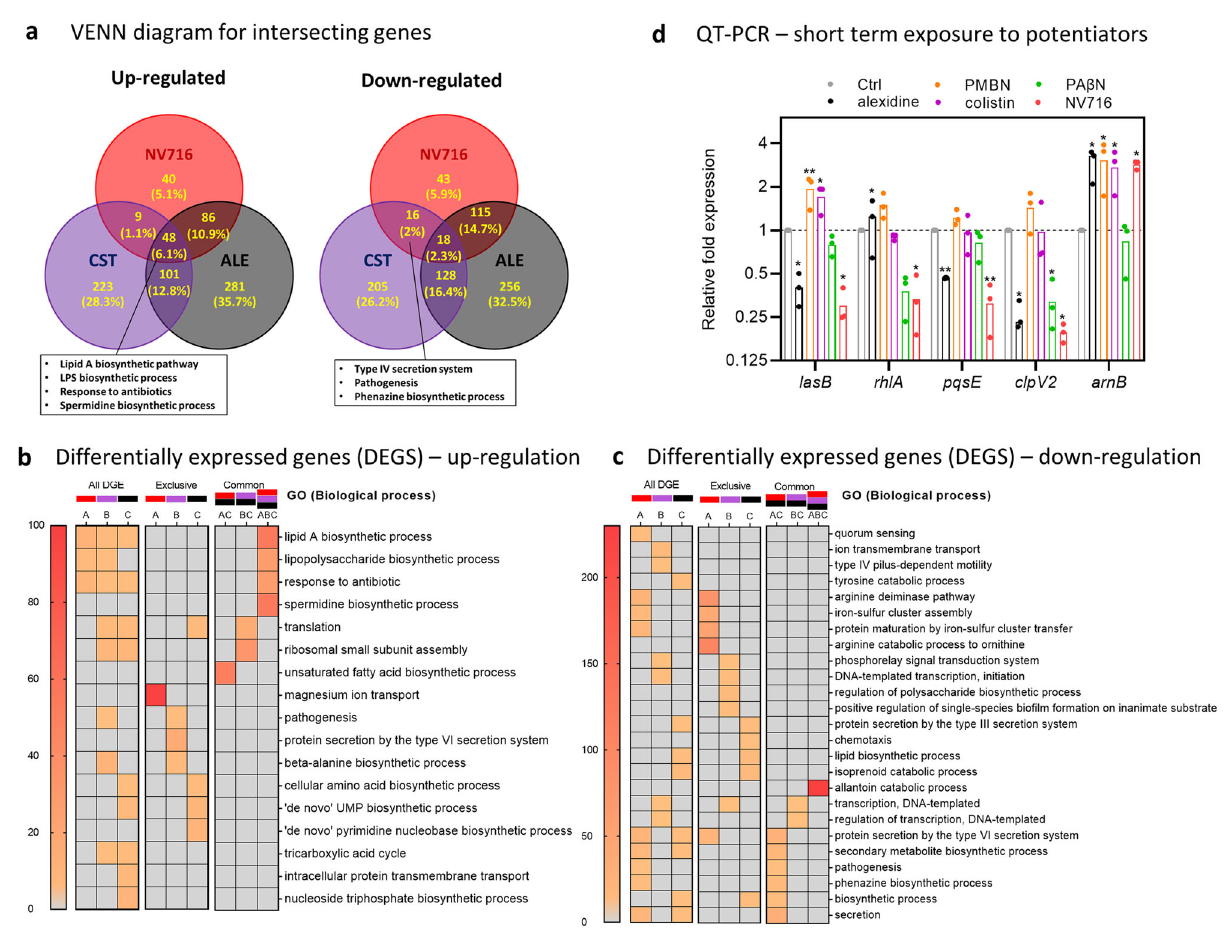
Fig. 6 Transcriptomic analysis of PAO1 after serial passages with selected potentiators. a Venn diagrams showing the commonly differentially expressed genes in PAO1 after 52 passages of culture in the absence or in the presence of NV716, colistin (CST) or alexidine (ALE) at ½ MIC. Pathways for intersecting genes that are relevant for this study are depicted in boxes. b , c GO term enrichment analysis of up- and downregulated genes, respectively, highlighting the biological functions that are exclusively regulated by a single potentiator or shared by two or three of them (A, red: NV716, B, purple: colistin, C, black: alexidine). The color gradient represents the value of the fold-change enrichment. All processes shown in these panels are signi fi cant (FDR < 0.05). d Relative expression of genes involved in the regulation of virulence or in LPS modi fi cations in PAO1 after 6 h of incubation in the absence (Ctrl, normalized to 1) of or in presence of potentiators at 38 µ M (PA β N) or ½ MIC (other molecules). Statistical analysis: a : the number of up- or downregulated genes is higher than expected by chance (higher than 97.5% of permutated data) for those up- or downregulated by the three potentiators or by NV716 and alexidine. d One-way ANOVA with Dunnett ’ s post-hoc test (* p < 0.05; ** p <